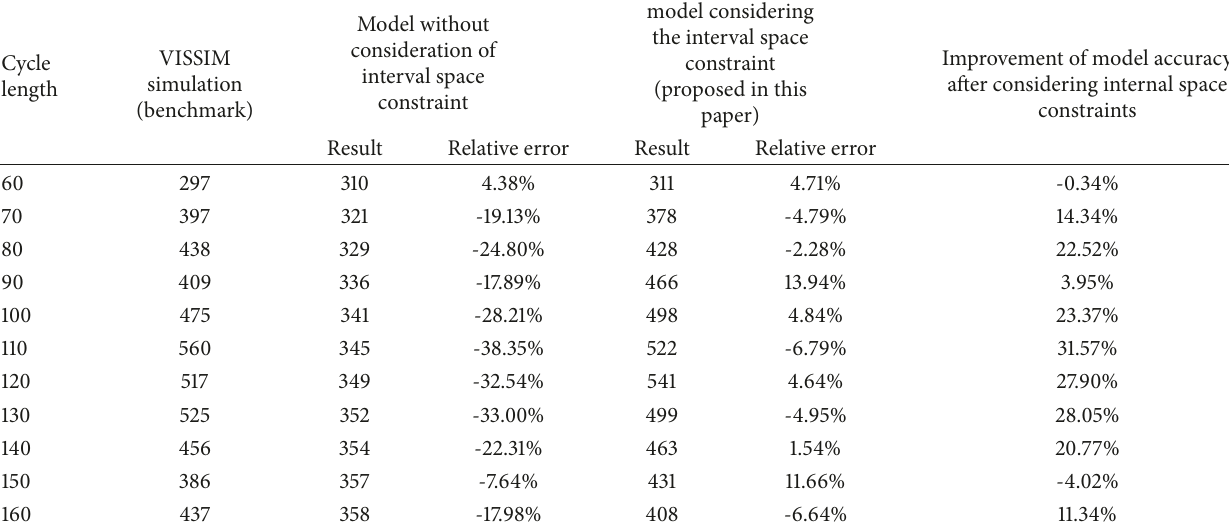
Table 2: The accuracy test